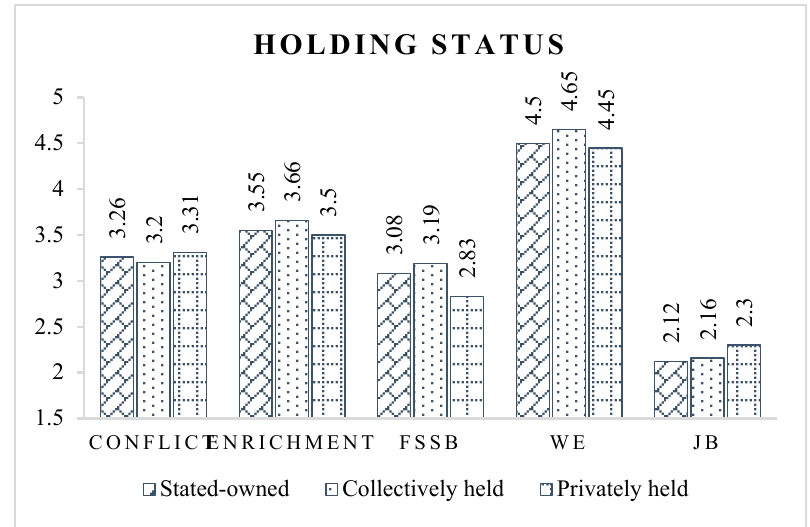
Figure 7. Latent variable scores of different holding status groups.